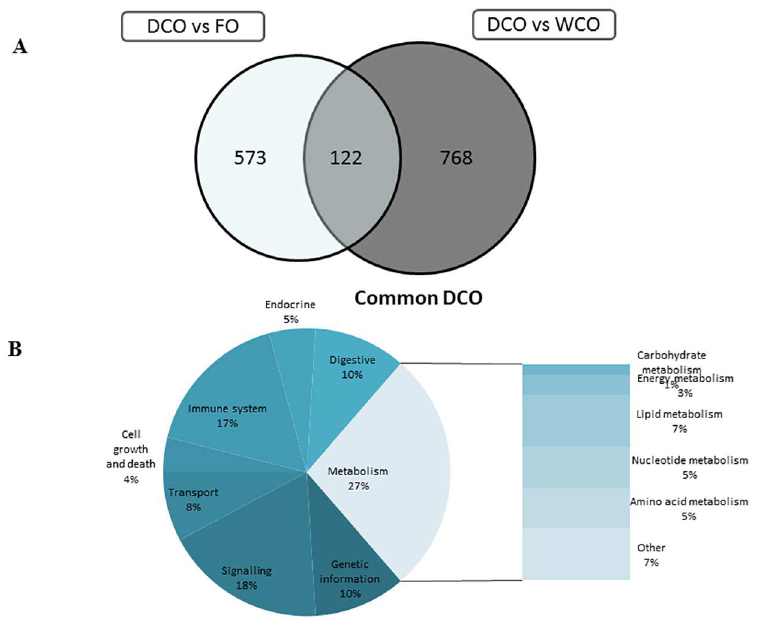
Fig 3. Impact of diet on midgut transcriptome of Atlantic salmon fed diets containing Fish Oil (FO) or Wild type Camelina Oil (WCO) in comparison with fish fed the EPA+DHACamelina Oil (DCO). (A) Venn diagramrepresentingtranscripts differentiallyexpressedin the midgut of Atlantic salmon fed diets FO and WCO comparedto diet DCO. The area of the circles is scaled to the number of transcripts (Welch t-test; p < 0.05; FC > 1.3). (B) Distributionby categoriesof common differentiallygenes in midgut betweenAtlantic salmon fed FO and WCO comparedto DCO-fed fish (Welch t-test; p < 0.05; FC > 1.3). Non-annotated genes and features corresponding to the same gene are not